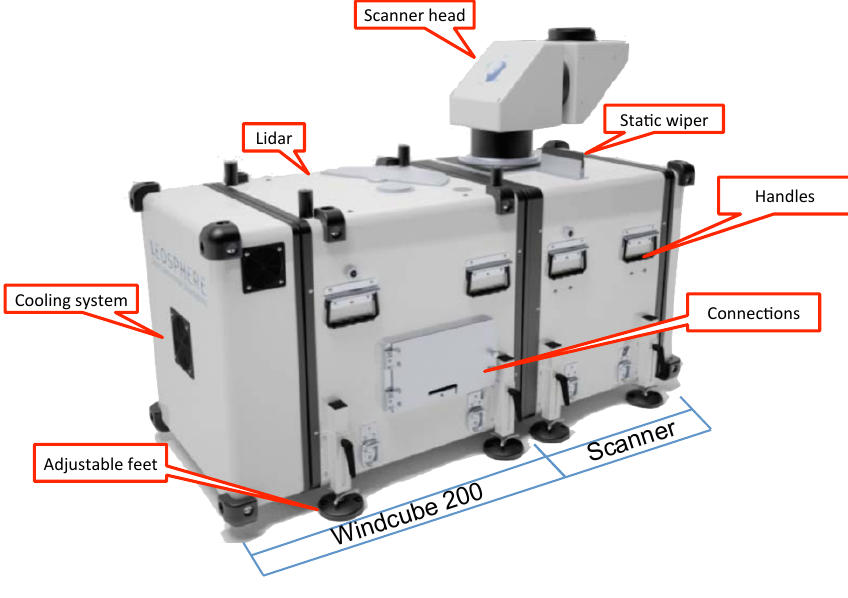
Figure 1. The long-range